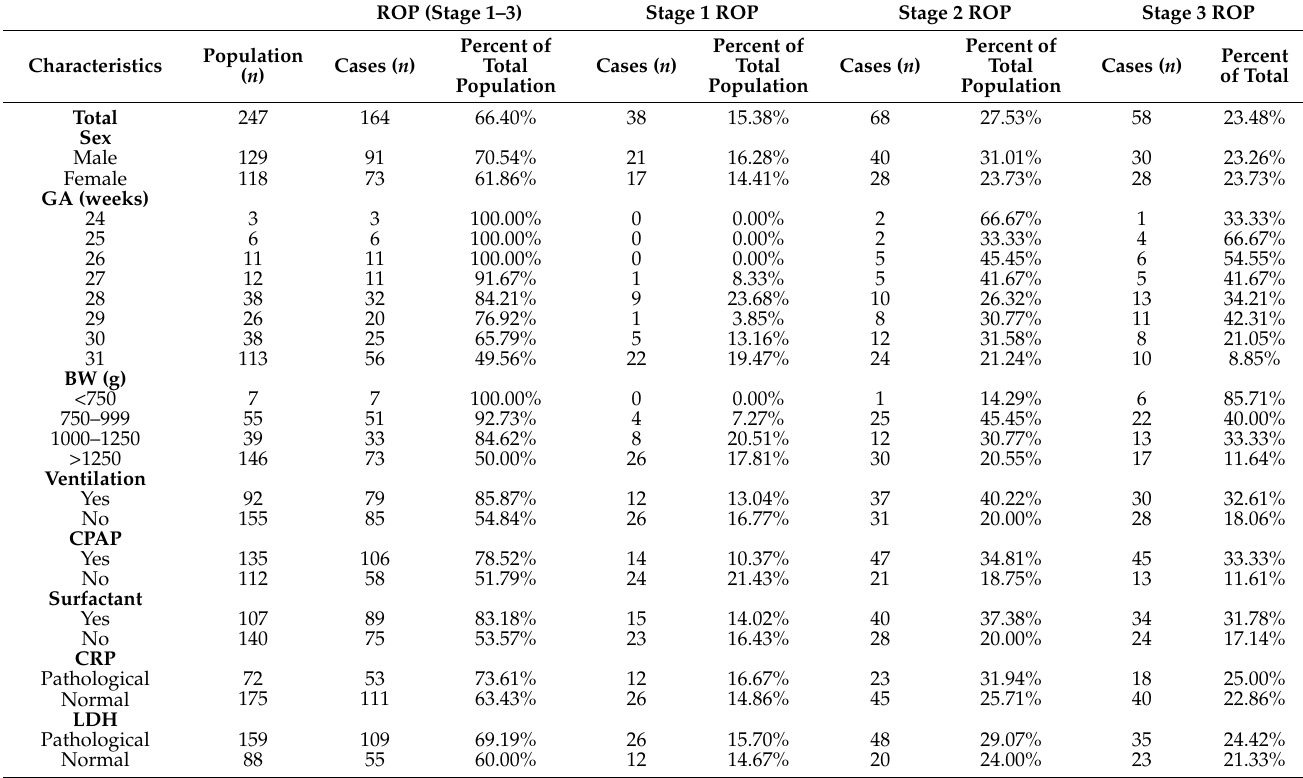
Table 1. Distributions of the various ROP groups by perinatal